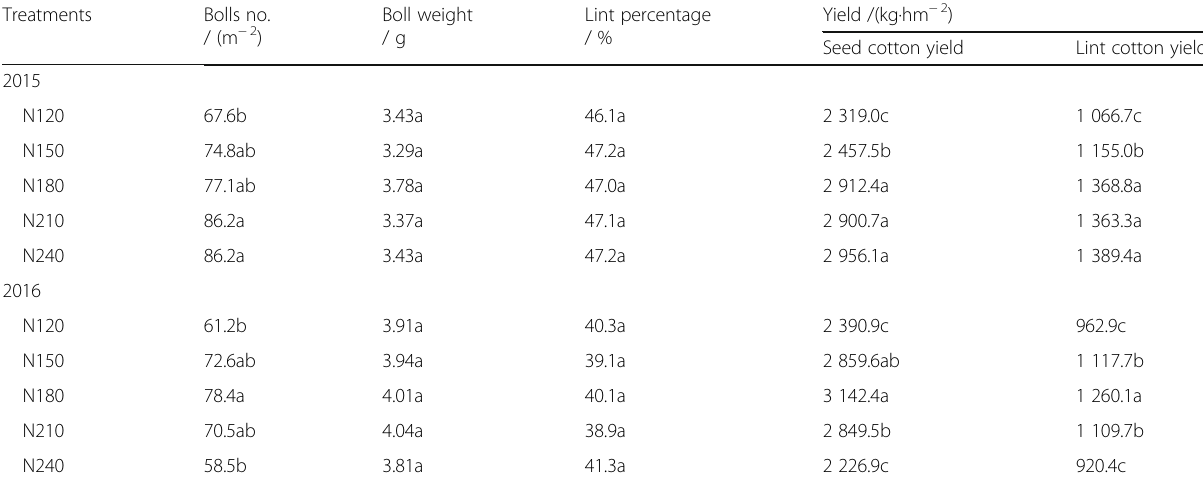
Table 2 Cotton yield and its components for different N rate in 2015 and 2016